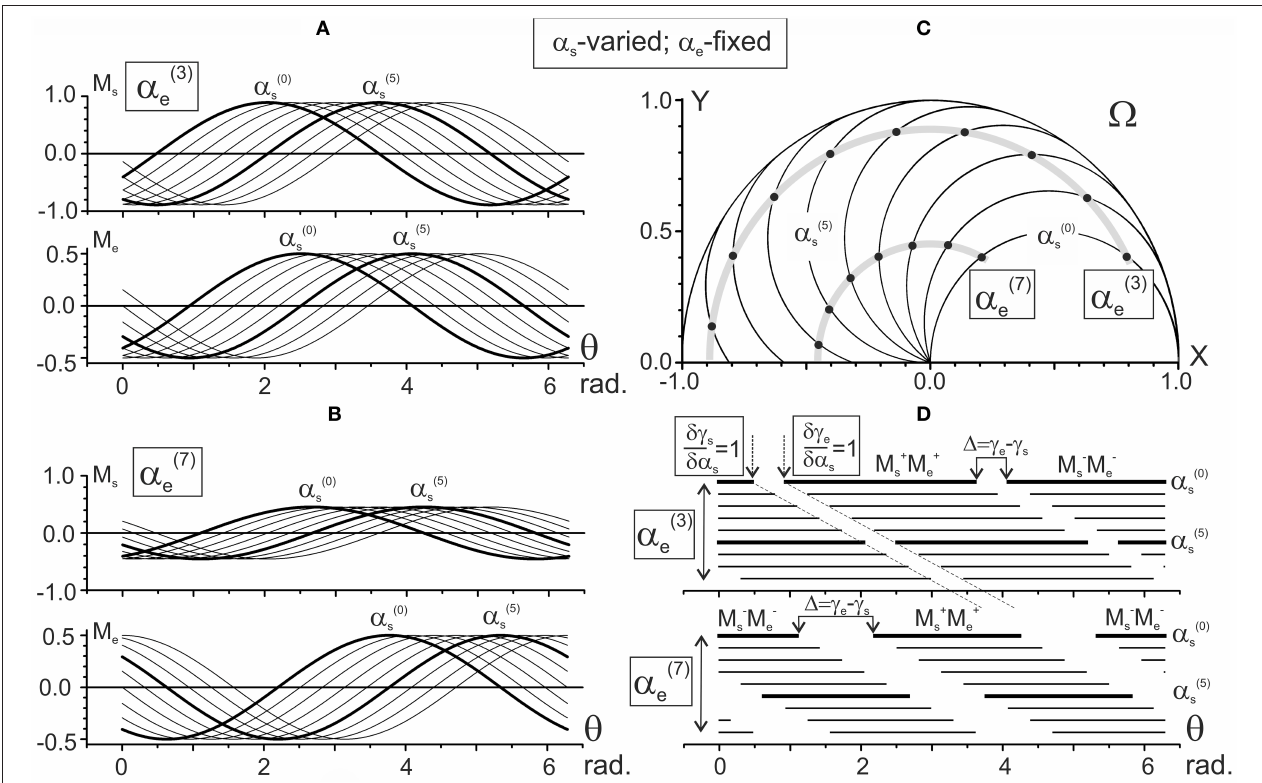
FIGURE 4 | Results of numerical simulation of the joint torques M s and M e (A,B) for different positions of the subject’s hand in the working space (cid:127) (C) . Two sets of the torque records with fixation of the elbow joint angle in positions 3 π /10 [ α (3) e ] and 7 π /10 [ α (7) e ] rad are chosen. The torques M s and M e are defined by Equation( 9) using the characteristic angles presented in Figure 2A . Thicker lines highlight the torque traces for shoulder positions α (0) s and α (5) s . Horizontal lines in (D) mark phases of the sign coincidence of the shoulder and elbow torques, both positive (M + s M + e ) and negative (M − s M − e ), in different traces. Throughout the study, the torques are defined for the action of unit forces at the hand positions; therefore, their calibrations are given in arbitrary